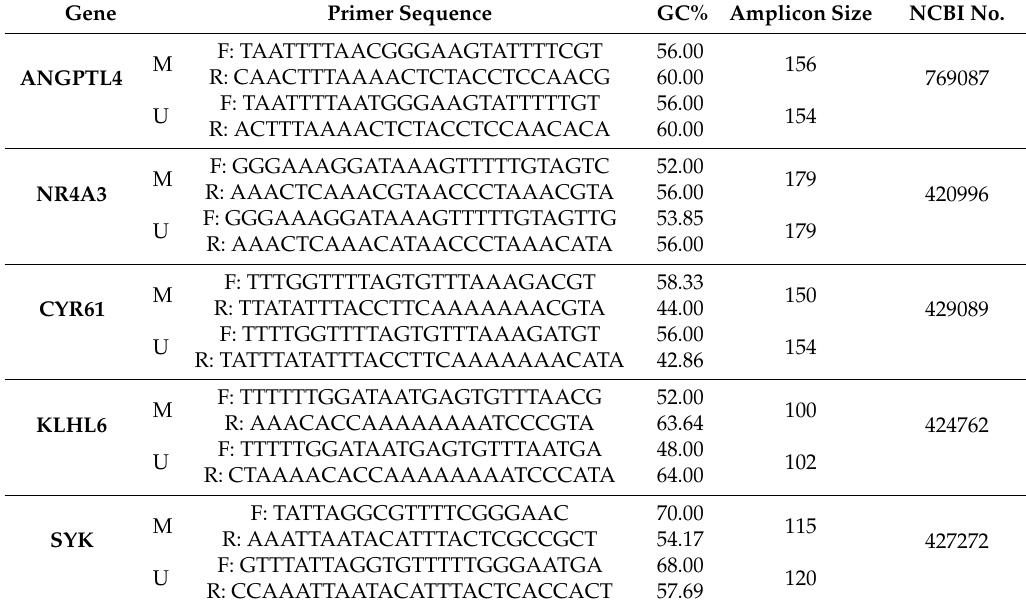
Table 1. Sequences of the primers designed for qMSP reaction by using the MethPrimer tool. Gene Primer Sequence GC% Amplicon Size NCBI